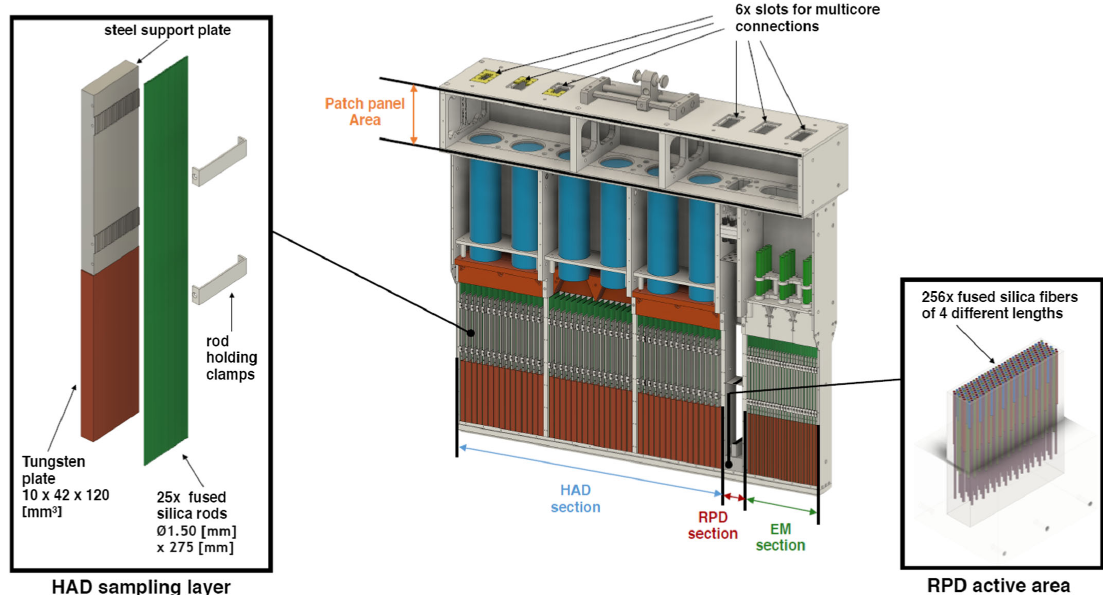
FIG. 13. HL ZDC detector design and